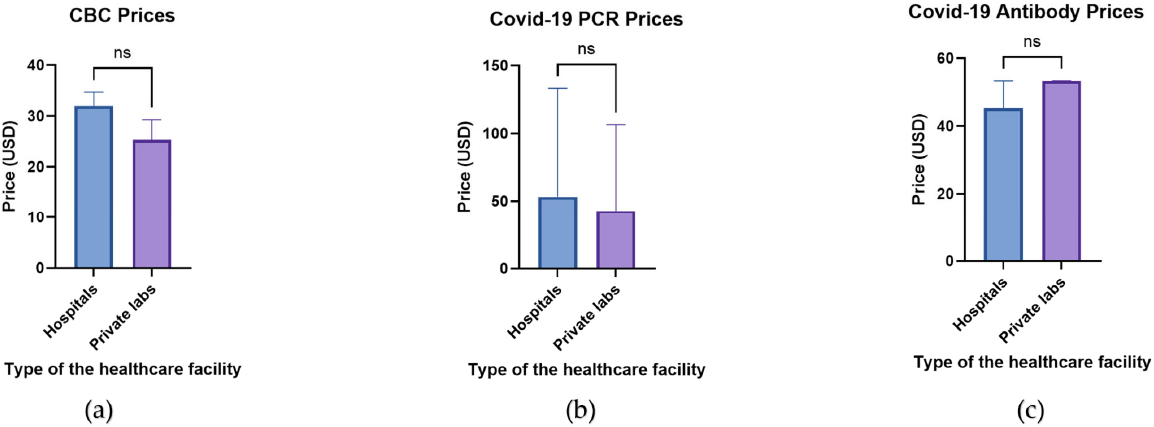
Figure 2. A comparison between the investigation prices at hospitals and private laboratories. The bar charts represent the prices of ( a ) CBC at hospitals (blue bars) as compared to private laboratories (purple labs). ( b ) The prices of COVID ‐ 19 PCR tests and ( c ) anti ‐ COVID ‐ 19 antibody titers are also demonstrated. The data demonstrate median values and IQR. ns: non ‐ significant; USD: United States dollars.